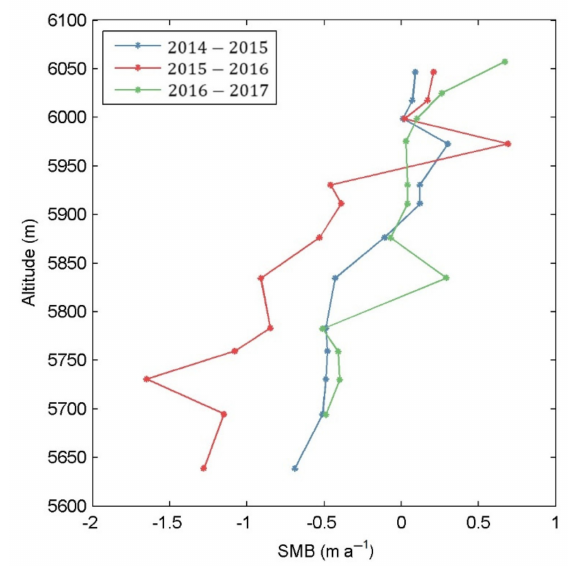
Figure 5. The observed SMB at stakes from August 2014 to August 2015 (blue), from August 2015 to October 2016 (red), and from October 2016 to October 2017